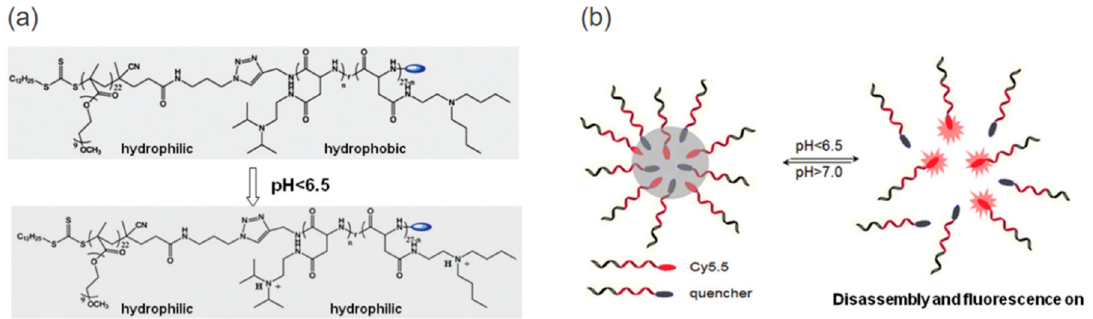
Figure 1. Design of ultra-pH-sensitive polypeptide micelles. ( a ) Structure of amphiphilic copolymers with ionizable tertiary amines and their transition at lower pH. ( b ) pH-triggered disassembly and fluorescence. Reproduced with permission from Liyi Fu, Pan Yuan, Zheng Ruan, Le Liu, Tuanwei Li, and Lifeng Yan, Polymer Chemistry; published by Royal Society of Chemistry, 2017.